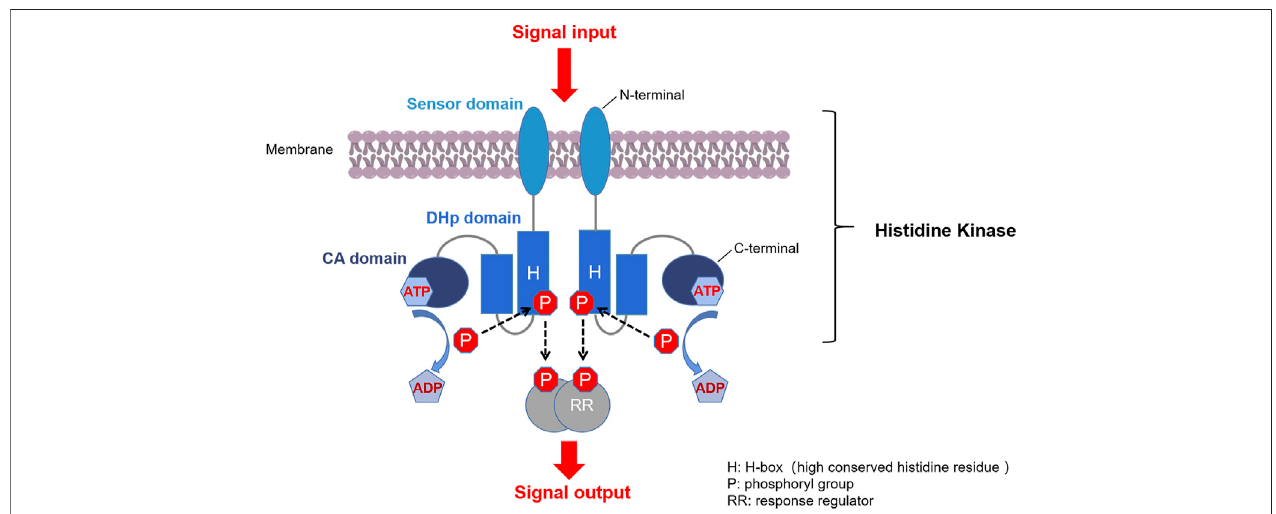
FIGURE1| TypicalTCSsignalingpathway.First,amembrane-boundHKhomodimersensesthesignalandisauto-phosphorylatedbyATPatthehistidineresidue. Second,thephosphorylgroup onthe phosphorylatedHK istransferred totheconservedaspartate at thereceiverdomain ofthe cognate RR. Third, thephosphorylated RR (P-RR) interacts with target genes or proteins, and intracellular responses are triggered accordingly. Finally, P-RR is dephosphorylated by modulation of intrinsic or HK-induced P-RR autophosphatase activity (Stock et al., 2000; Casino et al., 2009).